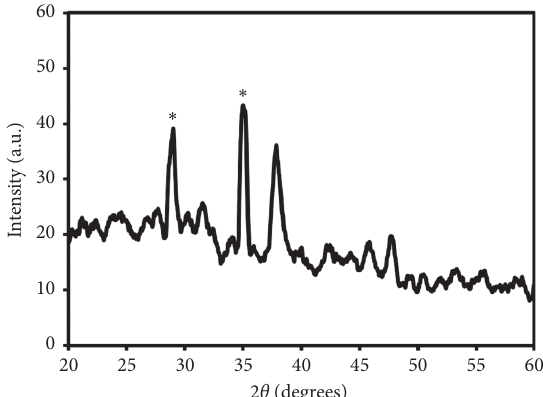
Figure 3: The XRD pattern of AgNPs. Ag metal peaks are shown with asterisk ( ∗ ).